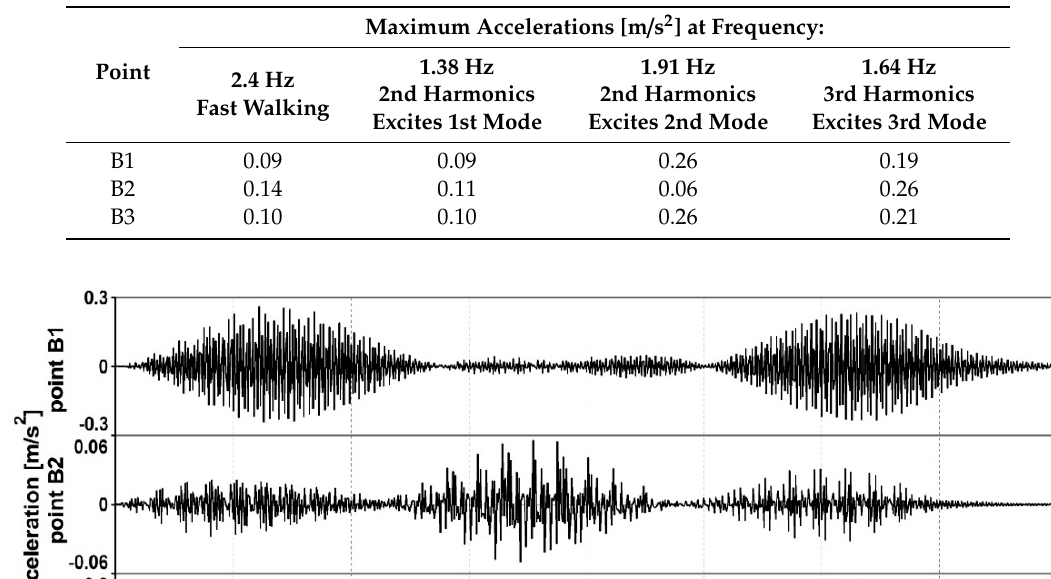
Table 13. Maximum vertical accelerations generated by a single pedestrian running obtained at the representative points of the beam footbridge with the RC slab for the selected frequencies. Maximum Accelerations [m / s 2 ] at Point